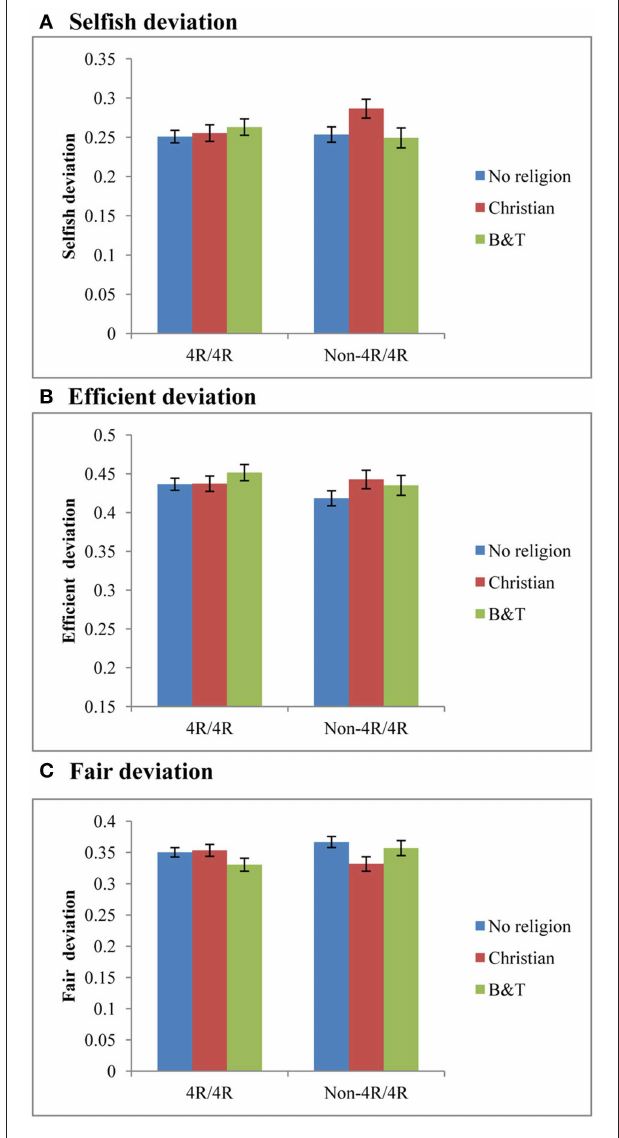
FIGURE 1 | Interaction effect of DRD4 and religious affiliation. Mean comparison of deviations from archetypical behaviors between religious affiliations, stratified by DRD4 exon III genotype. (A) Shows Selfish deviation, (B) shows Efficient deviation, and (C) shows Fair deviation. The blue bars are No religion group, red bars are the Christian group, and green bars are the B-T group. Error bars are SEM.